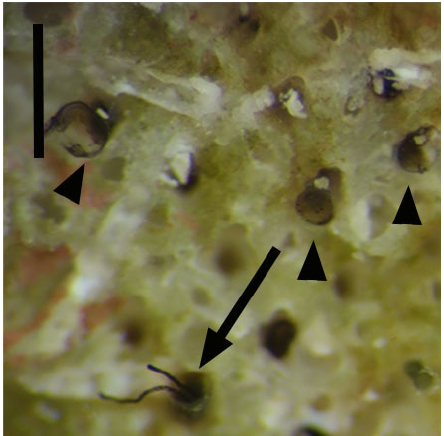
Figure 12. Experimental zooids and colony. Some of the removed erect tubes were closed with a lid secreted by the zooids (arrowheads). The lid on the left is broken. Scale bar 80 µm.